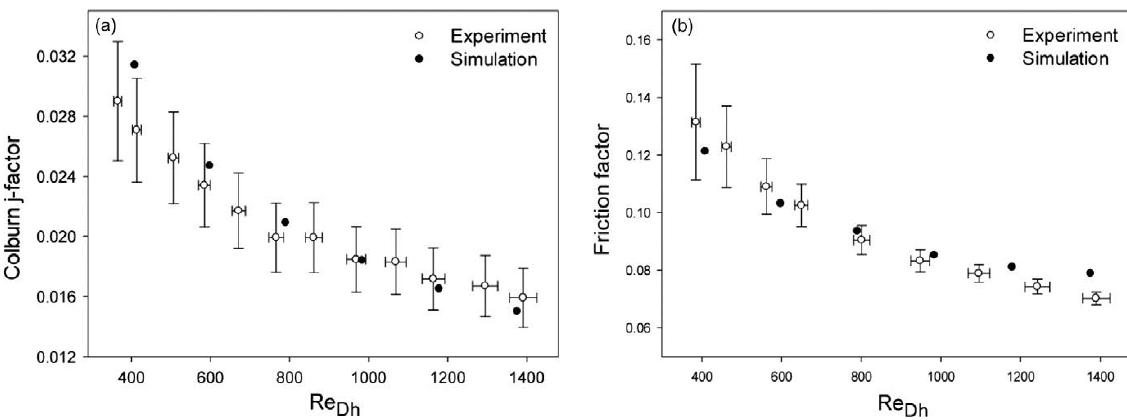
Figure 15: Comparison between the experimental data and the simulation results: (a) Colburn j-factors and (b) friction factors